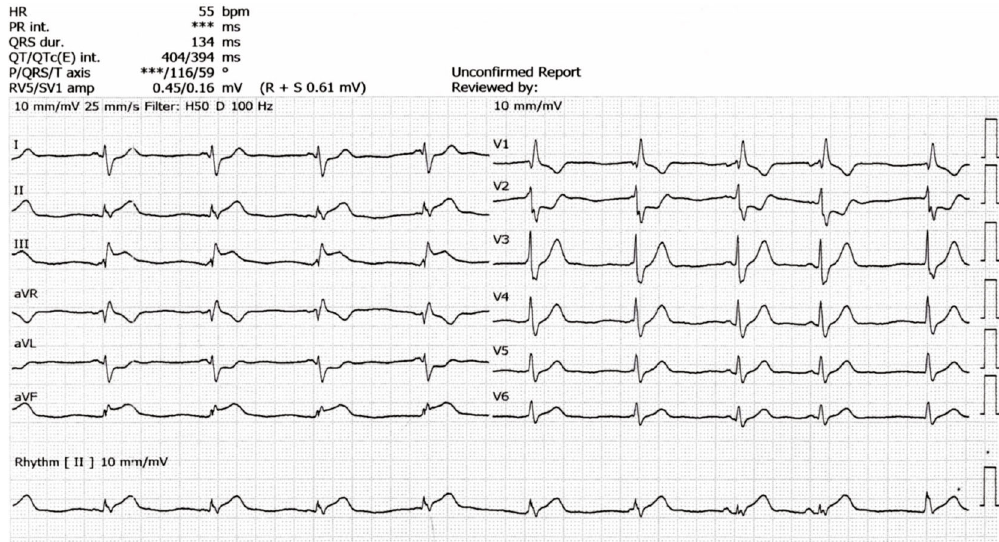
Figure 3: Electrocardiogram (ECG) shows ST segment elevation in the inferior